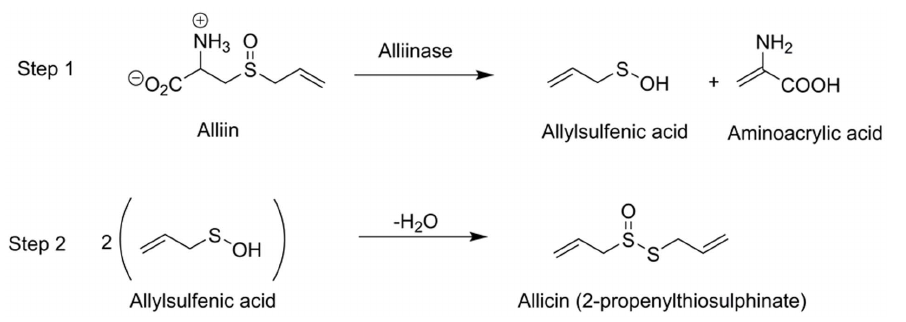
Figure 1. Chemical structure of allicin and mechanism of formation from alliin by the enzyme alliinase. Step 1. Alliinase hydrolyses alliin to produce allylsulfenic acid which, in step 2, condenses spontaneously with the loss of water to produce